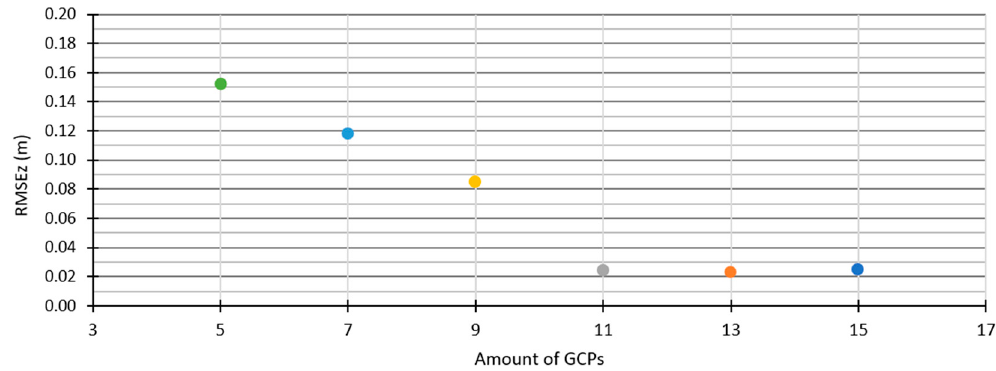
Figure 12. Relationship between the amount of GCPs and RMSEz.